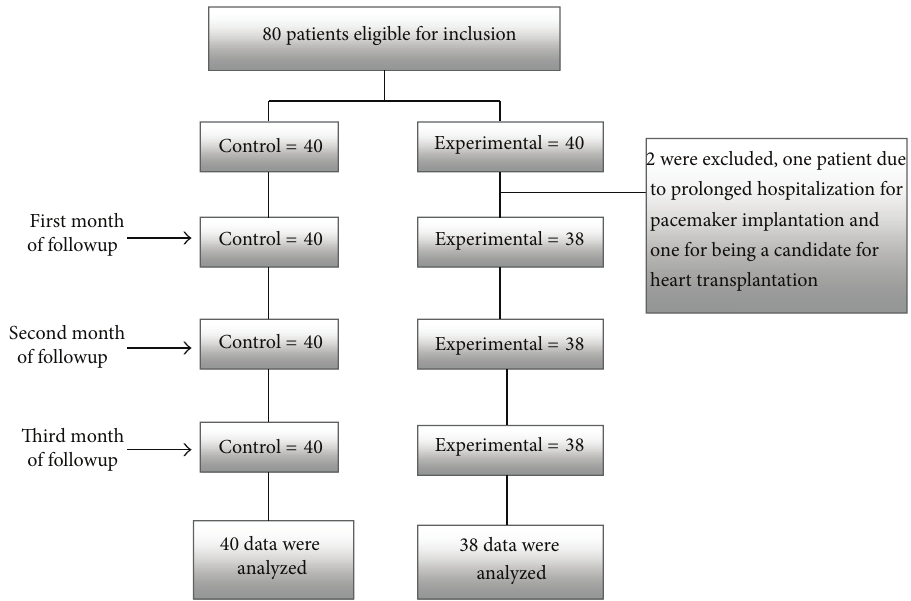
Figure 1: Randomization flow